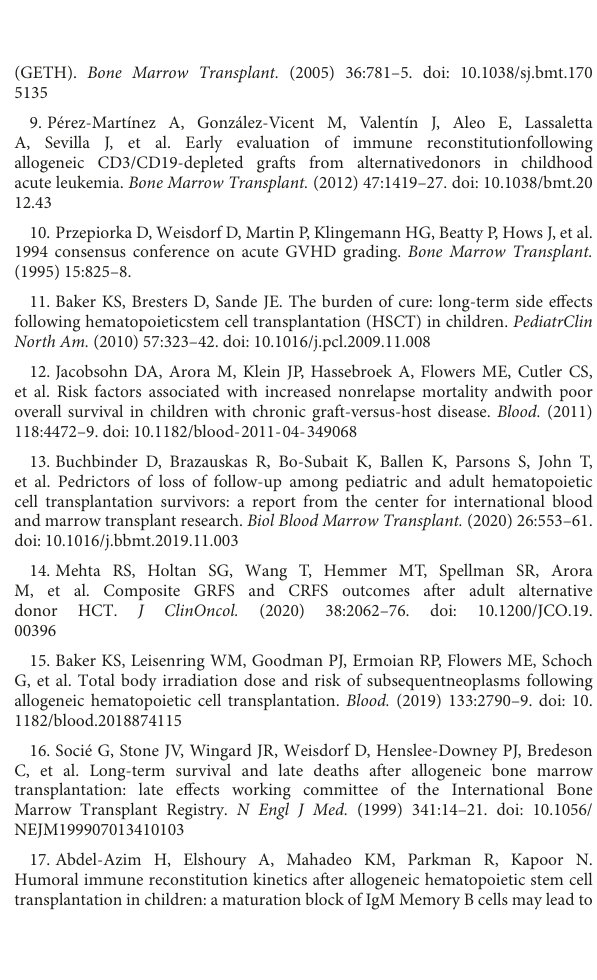
SUPPLEMENTARYFIGURE1 Immune reconstitution and non-relapse mortality. (A) One-year T lymphocytes/ µ l. (B) One-year CD8 lymphocytes/ µ . (C) One-year CD4 lymphocytes/ µ l. (D) One-year B lymphocytes/ µ l. Yes means patient died because of non-relapse causes. SUPPLEMENTARYFIGURE2 Receiver operating characteristic(ROC) curve. The 80% specificity for CD4+ cells is 786/ µ l, and the area under the ROC curve (AUC)